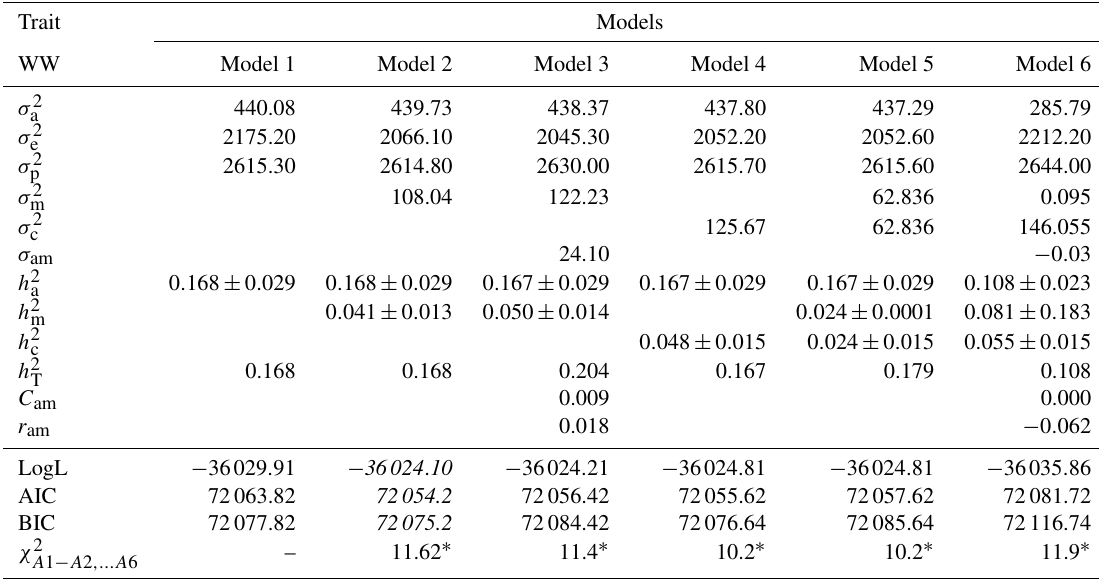
Table 4. Estimates of (co)variance components and genetic parameters for WW of Awassi lambs obtained in different models (mean ± standard error). The best models according to LogL, AIC and BIC criteria are shown in